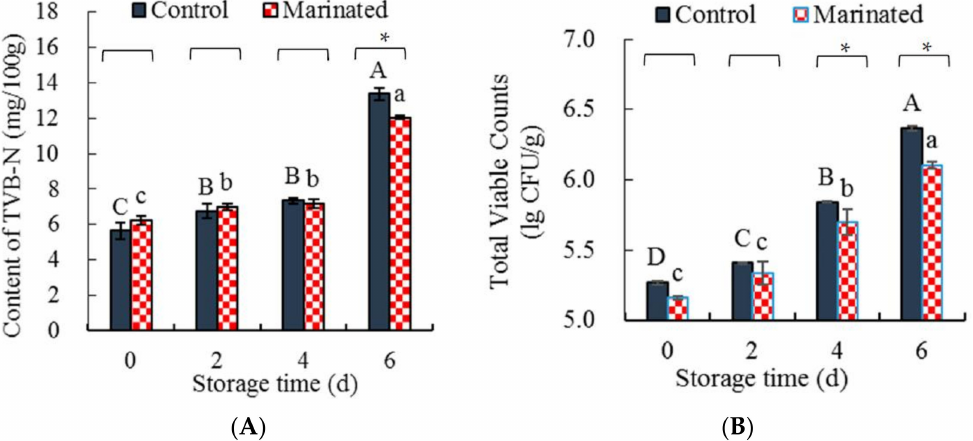
Figure 4. The TVB-N ( A ) and viable count ( B ) of the marinated pork and the control. Values are presented as mean ± standard deviation. Different letters above the bars highlighting the standard deviations indicate significant differences ( p < 0.05). The asterisk indicates significant differences ( p < 0.05) between treatments for each